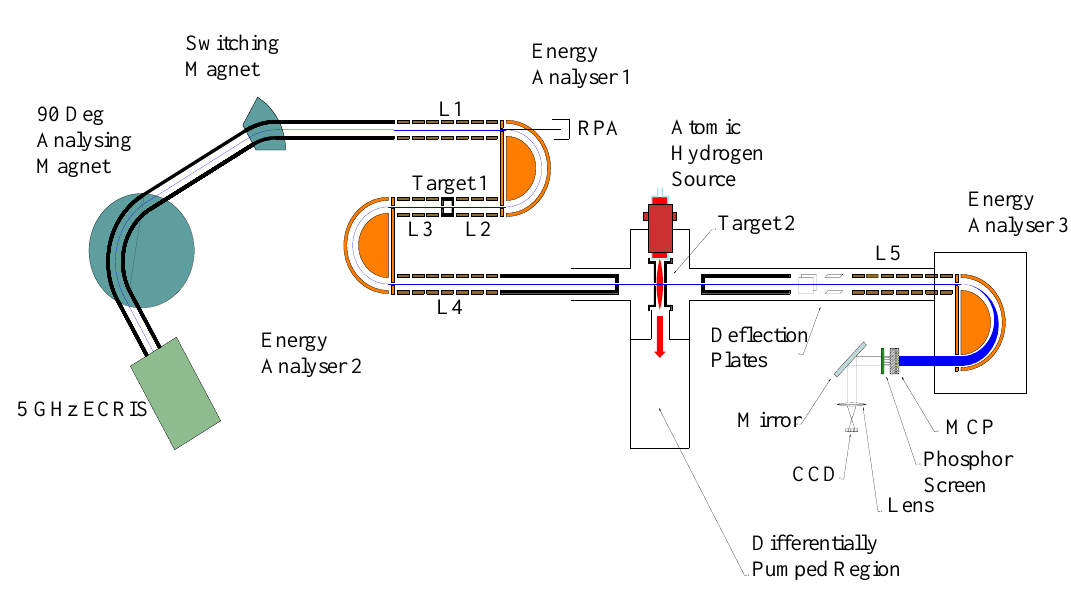
Figure 1: Schematic Diagram of DTES